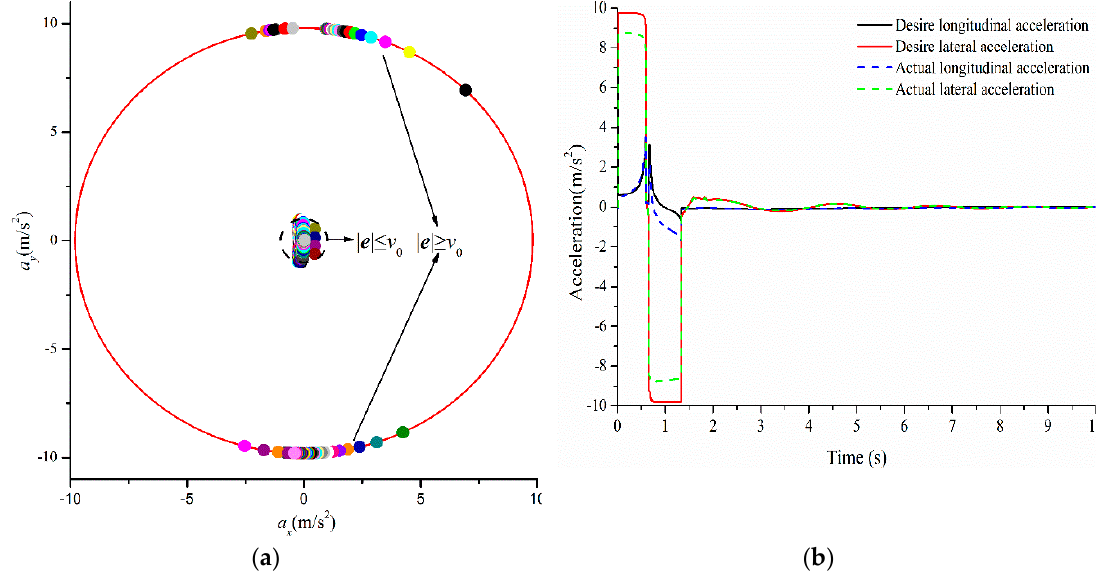
Figure 12. The usage of tire force and acceleration curve: ( a ) The usage of friction circle; and, ( b ) The comparison between desire acceleration and actual acceleration.